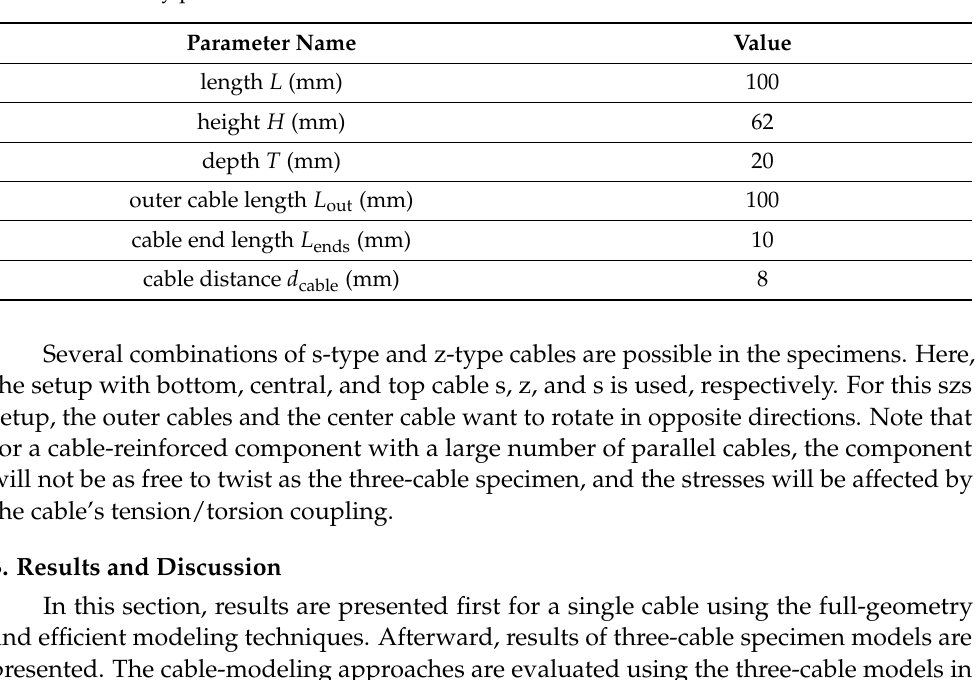
Table 3. Geometry parameters of the three-cable